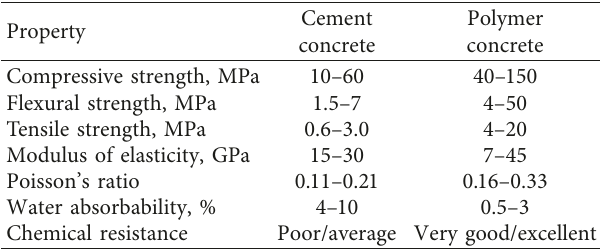
Table 1: Properties of cement concrete and polymer concrete adapted from Czarnecki and Lukowski [18] and Czarnecki